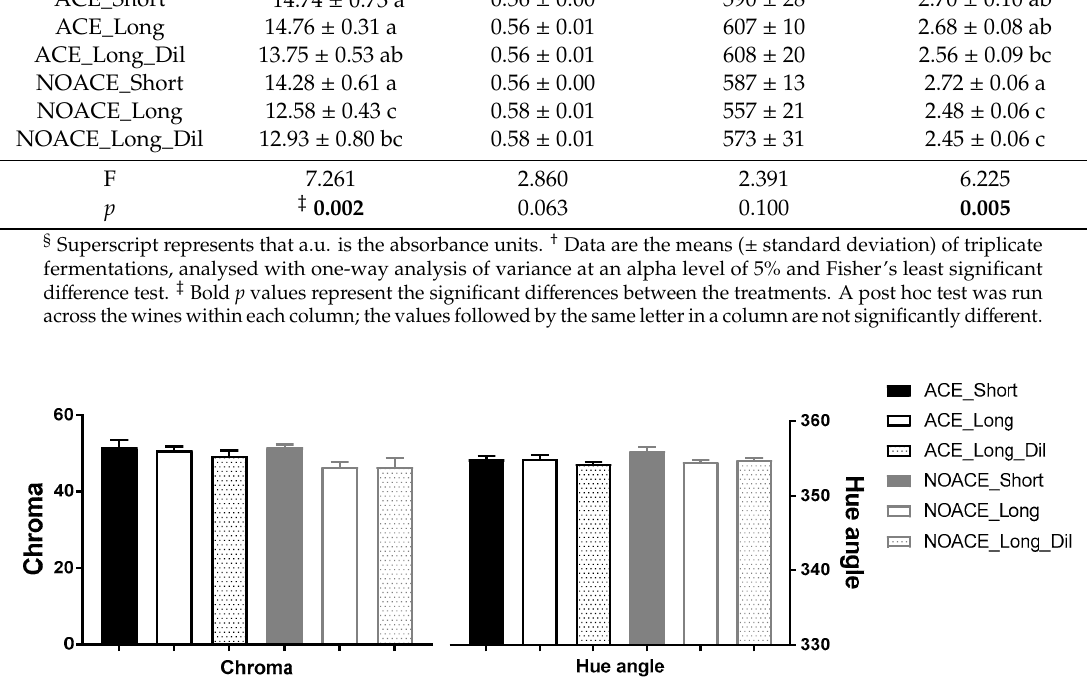
Figure 3. The colour of wines measured by CIELab. Shiraz wines were prepared following NOACE and ACE maceration with either 3 days (Short) or 6 days (Long) on skins, or 6 days on skins with pre-fermentation water dilution to 13.5 B é (Long_Dil). Results are presented as the chroma and hue angle (mean ± standard deviation of triplicate fermentations).